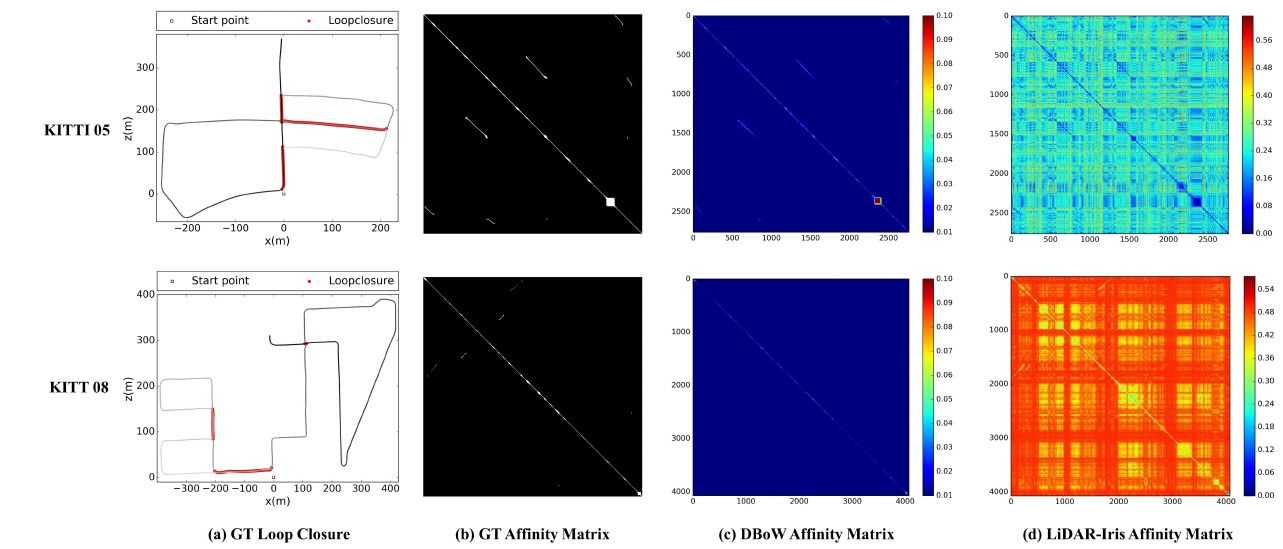
Figure 8. Affinity matrices obtained by the Bow and LiDAR-Iris method on two sequences. The first row corresponds to KITTI sequence 05, and the second row corresponds to KITTI sequence 08. ( a ) Ground Truth loop closure with trajectory. ( b ) Ground truth affinity matrix. ( c ) BoW affinity matrix and ( d ) is LiDAR-Iris affinity matrix